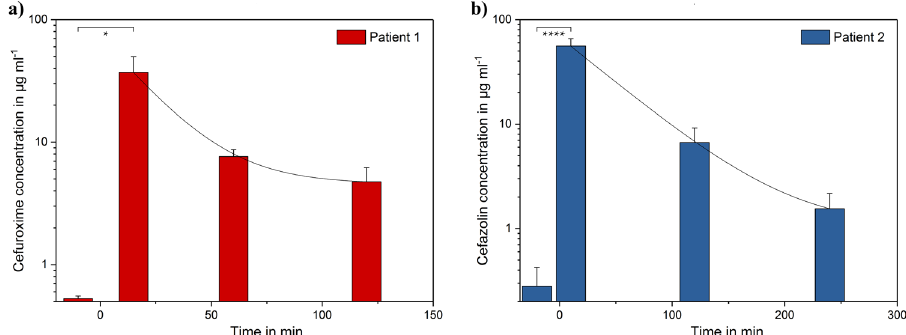
Figure 4. Clinical results of the on-site monitoring of two patients, undergoing surgery. The serum was diluted 1:500 in PBS and measured 4 times for each patient. The initial measurement was completed before the patients received their infusion (t = 0 min), the second 10 to 15 min after the infusion and the third and fourth measurement was performed after 90 and 180 min for cefuroxime and 120 and 240 min for cefazolin. ( a ) Patient 1 received cefuroxime, while patient 2 ( b ) received cefazolin as antibiotic. The data were analysed by an unpaired parametric two-tailed t-test ( * P < 0.005, **** P < 0.0001).